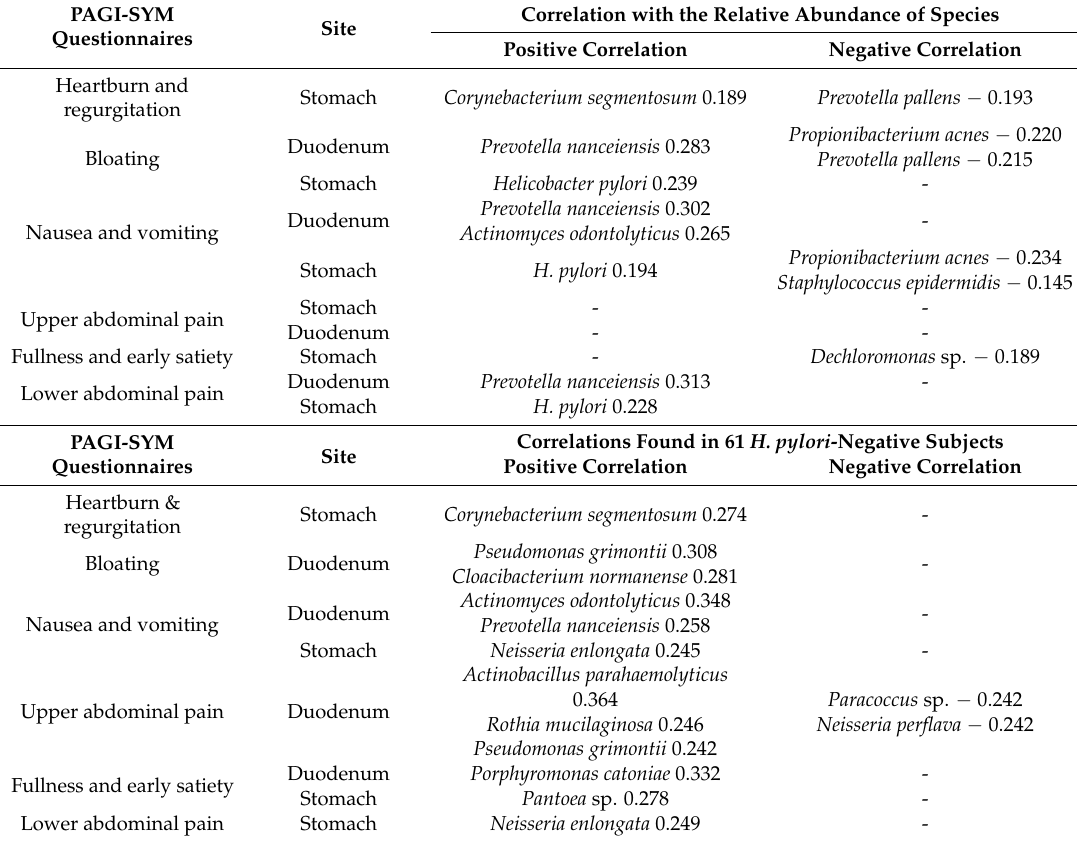
Table 3. Gastric and duodenal microbiota correlated with the Patient Assessment of Gastrointestinal Disorders Symptom Severity Index (PAGI-SYM)